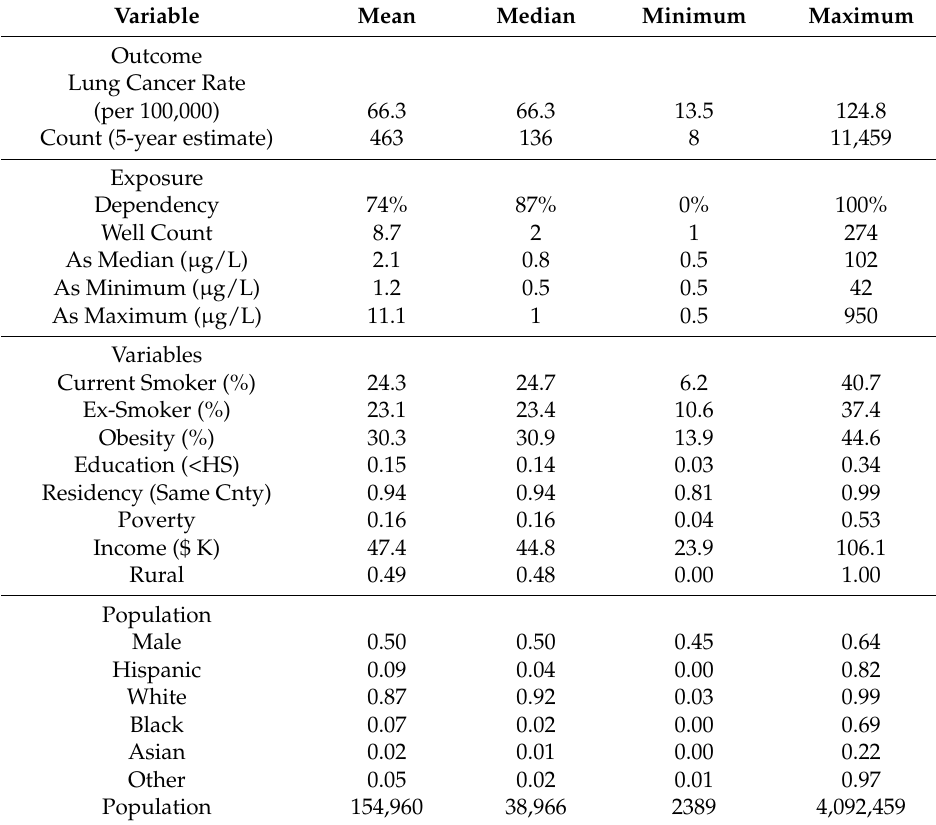
Table 1. Data characteristics of analytic variables for individual